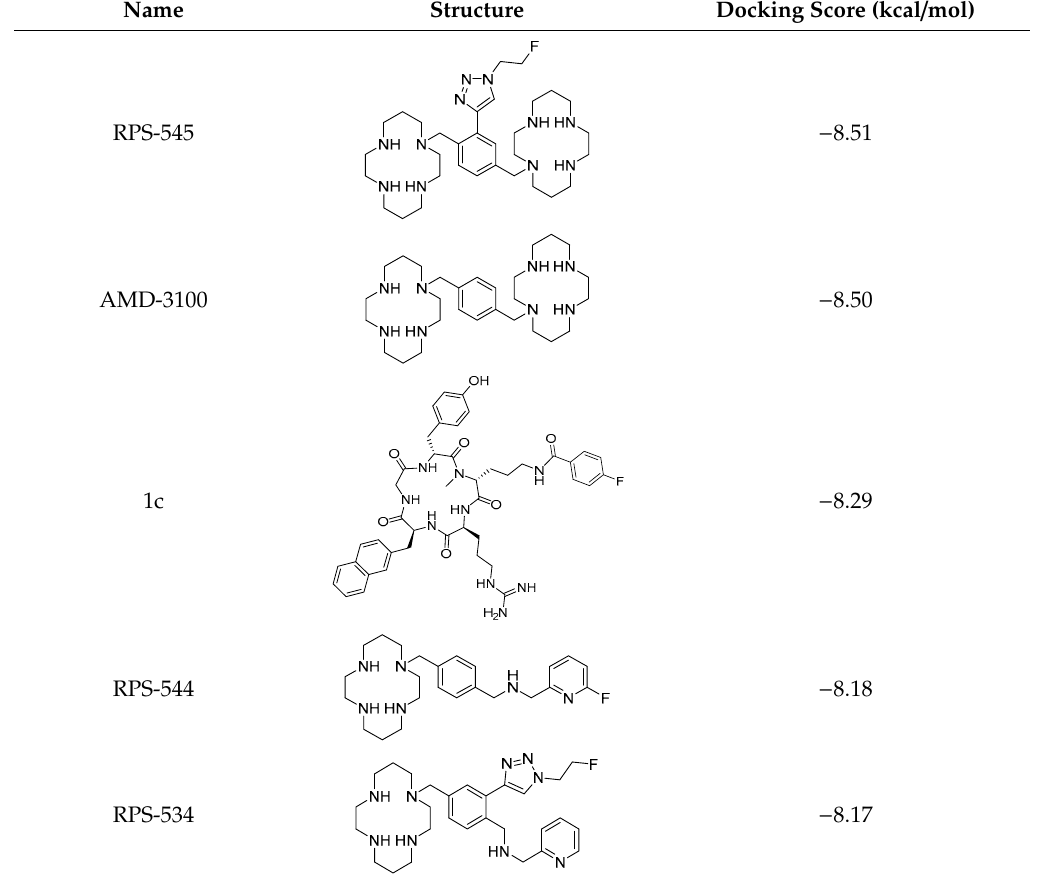
Figure 1. AMD-3465, the parent structure for derivatization. Fluorine was introduced by addition or substitutions of chemical moieties at rings B and C. The resulting library of structures were screened in silico against human CXCR4 (PDB ID: 3ODU) using Schrodinger. Table 1. Comparison of docking scores of six candidate CXCR4 ligands with known ligands with high affinity. Docking score was determined in an extra precision screen against human CXCR4 (PDB ID: 3ODU) using Schrodinger. The highest docking score is reported for each compound.